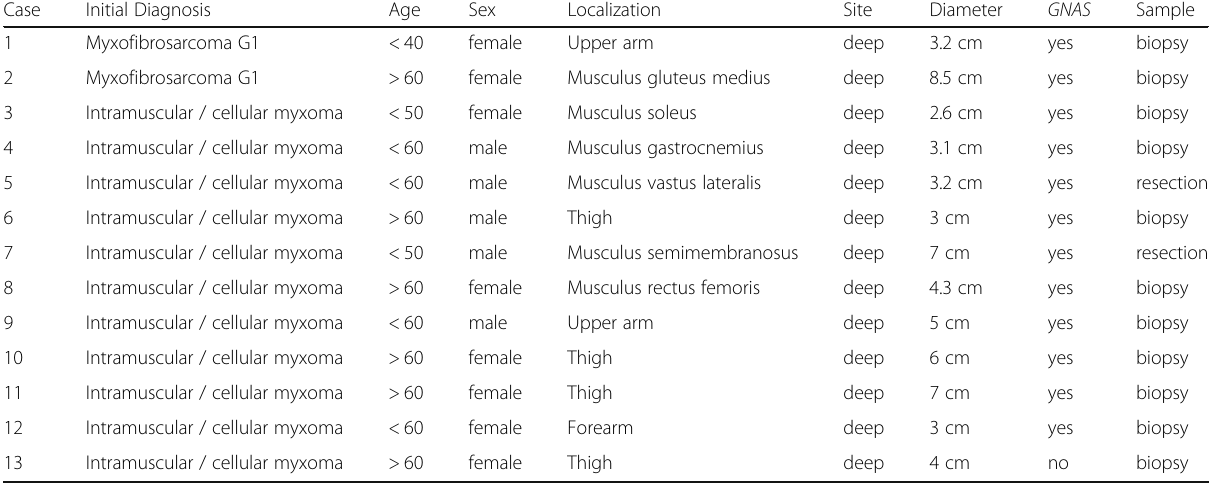
Table 1 Clinicopathological data of our cases